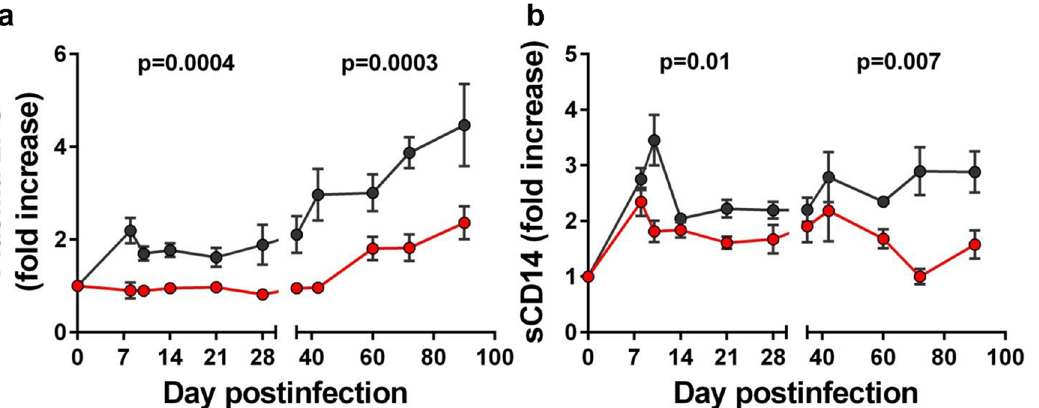
Fig 1. Rifaximin (RFX) + sulfasalazine (SFZ) treatment reduces microbial translocation during early SIVsab infection of pigtailed macaques (PTMs). (a) Comparison between plasma LPS levels in SIVsab-infected PTMs receiving RFX+SFZ (red) and untreated controls (black). (b) Comparison between plasma sCD14 levels in SIVsab-infected PTMs receiving RFX+SFZ (red) and untreated controls (black). The average values for each group and standard error of means are shown.